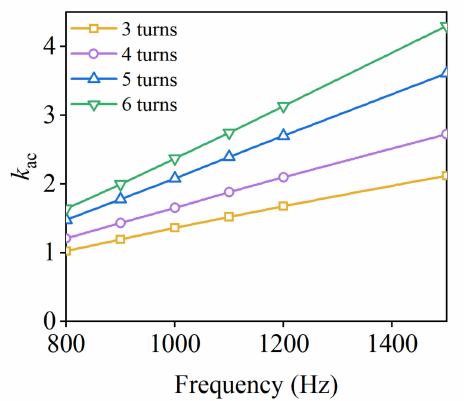
Figure 18. AC/DC copper loss ratio k ac with conductor turns at different